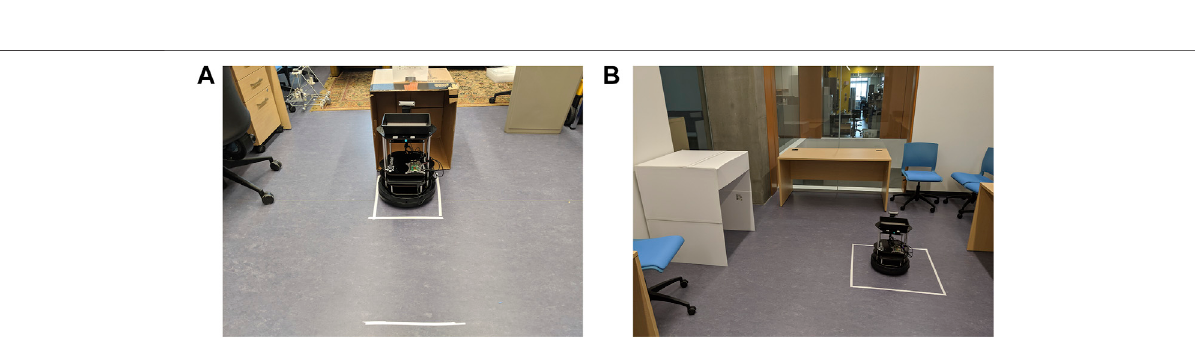
FIGURE 2 | Experimental setup for speech recognition evaluation and delivery scenario